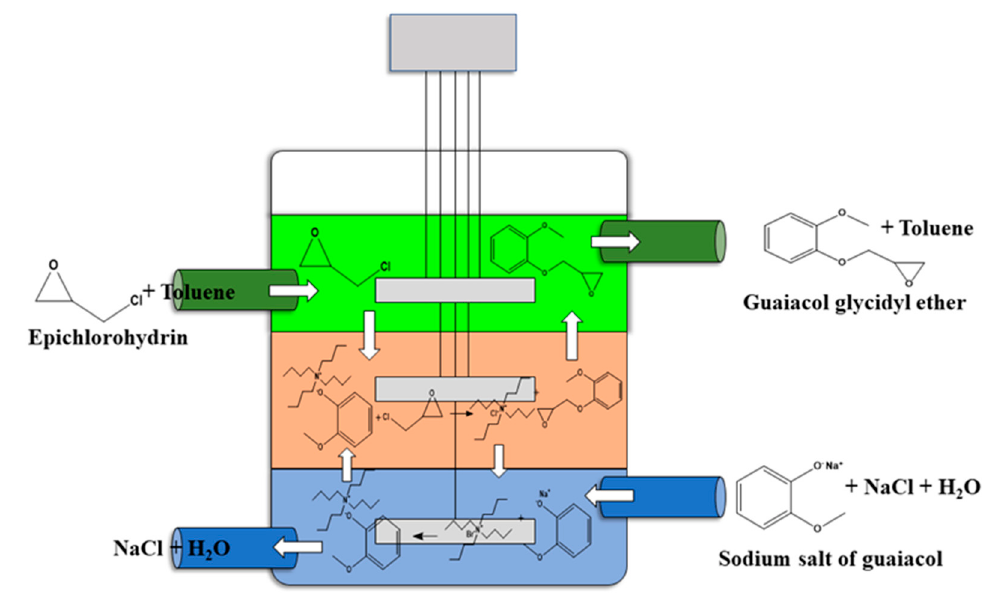
Figure 3. Liquid-liquid-liquid (L-L-L PTC) reaction in a continuous flow stirred multiphase reactor.